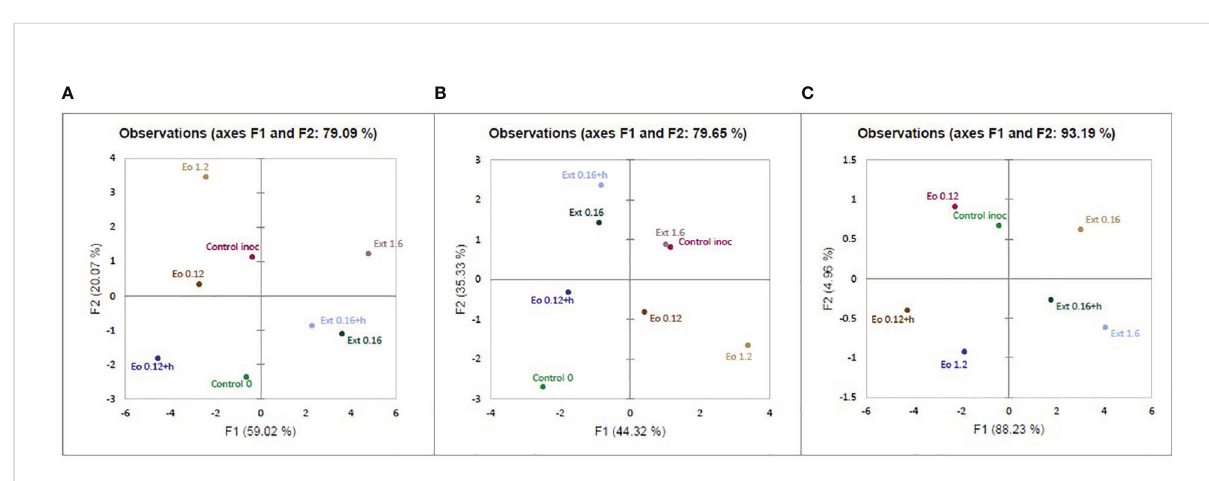
FIGURE 4 Principal component analysis (PCA) of: combined extracts antifungal activity and treated strawberry plants physiological data (A) ; only treated strawberry plants physiological data (B) , and only extracts antifungal activity data (C) .